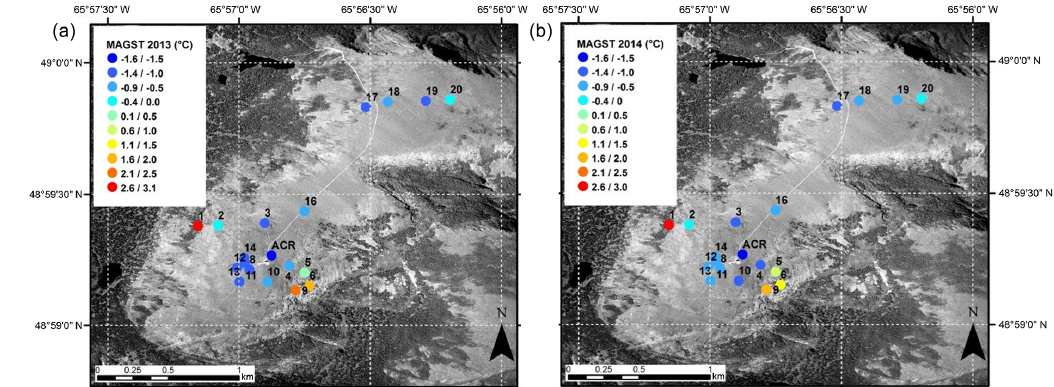
Figure 7. Maps of the mean annual ground surface temperature (MAGST) recorded at the summit in 2013 and 2014.